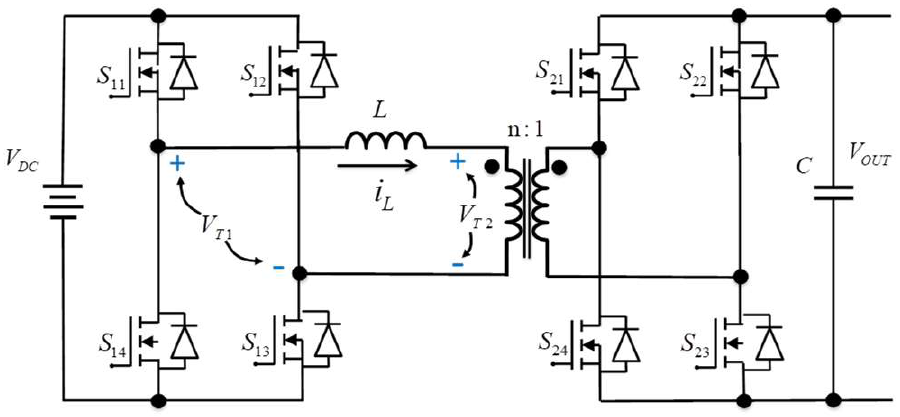
Figure 1. Dual active bridge (DAB) converter.